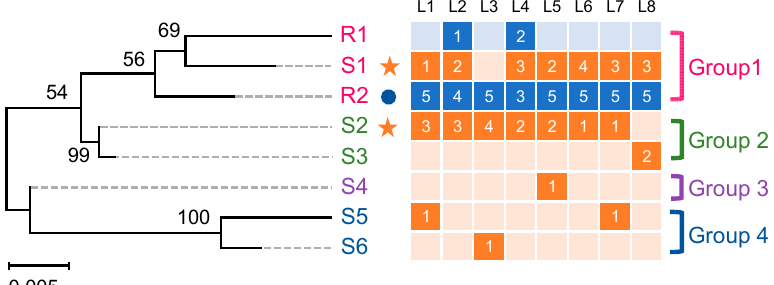
Figure 1. Phylogenetic relationships of PxABCG1 promoter sequences amplified from the Bt-susceptible strain DBM1Ac-S and the Bt-resistant strain NIL-R. The phylogenetic tree was generated using the maximum likelihood (ML) method based on the model optimized using the Bayes Information Criterion with “complete deletion” as the gaps/missing data treatment and 1000 bootstrap replications. The classification of different PxABCG1 promoter sequences is shown on the right. Promoter sequences of the PxABCG1 gene were amplified from 8 susceptible DBM1Ac-S larvae and 8 resistant NIL-R larvae, respectively. L1 to L8 above represents each susceptible or resistant larva, and five clones from each larva were sequenced. Squares shaded in orange and blue represent susceptible and resistant larvae, respectively, and the number within the squares shows the number of the corresponding promoter detected in the 5 sequenced clones per larva. The orange star and the blue circle denote the major type of PxABCG1 promoter sequences in the susceptible and resistant larvae, respectively.